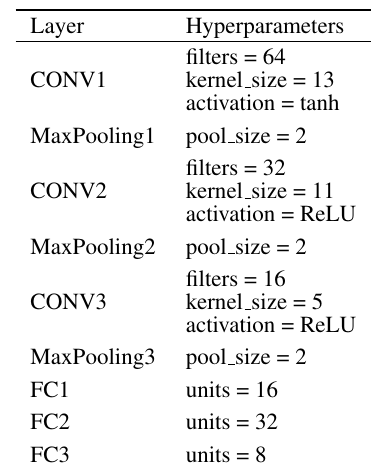
Figure 3. Flowchart of our developed CNN. The DL network combines convolutional layers (CONV), fully-connected (FC), and max-pooling (MaxPooling) layers. The output of each layer is presented as a vertical bar annotated with its corresponding shape. Details on the parameters of individual layers are given in Table 3. Table 3. Hyperparameters of the applied CNN visualized Table 4. Results of the applied ML models, RF and CNN, for the in Figure 3. dataset I and II on the classification task event vs. no event